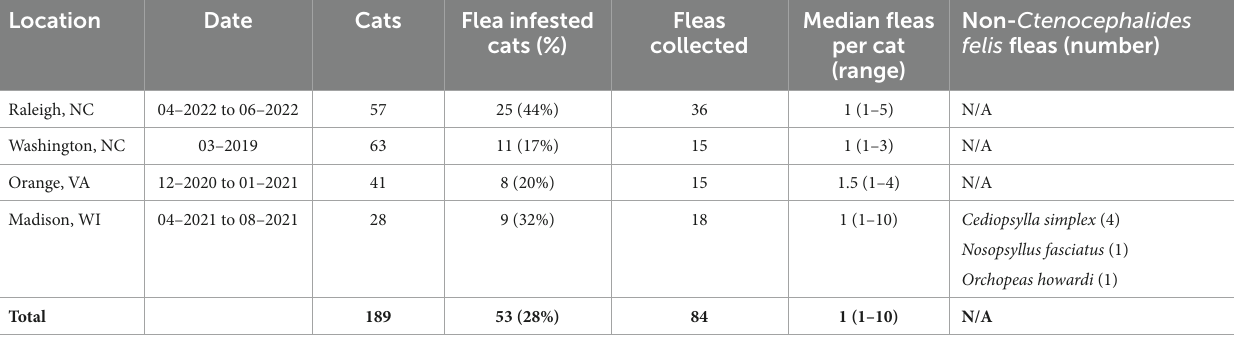
TABLE 2 Summary of sampling based on geographic location of origin including the dates of sampling, total number of cats, number of flea infested cats, total number of fleas, median number of fleas per infested cat (and range), and summary of non- Ctenocephalides felis sampled